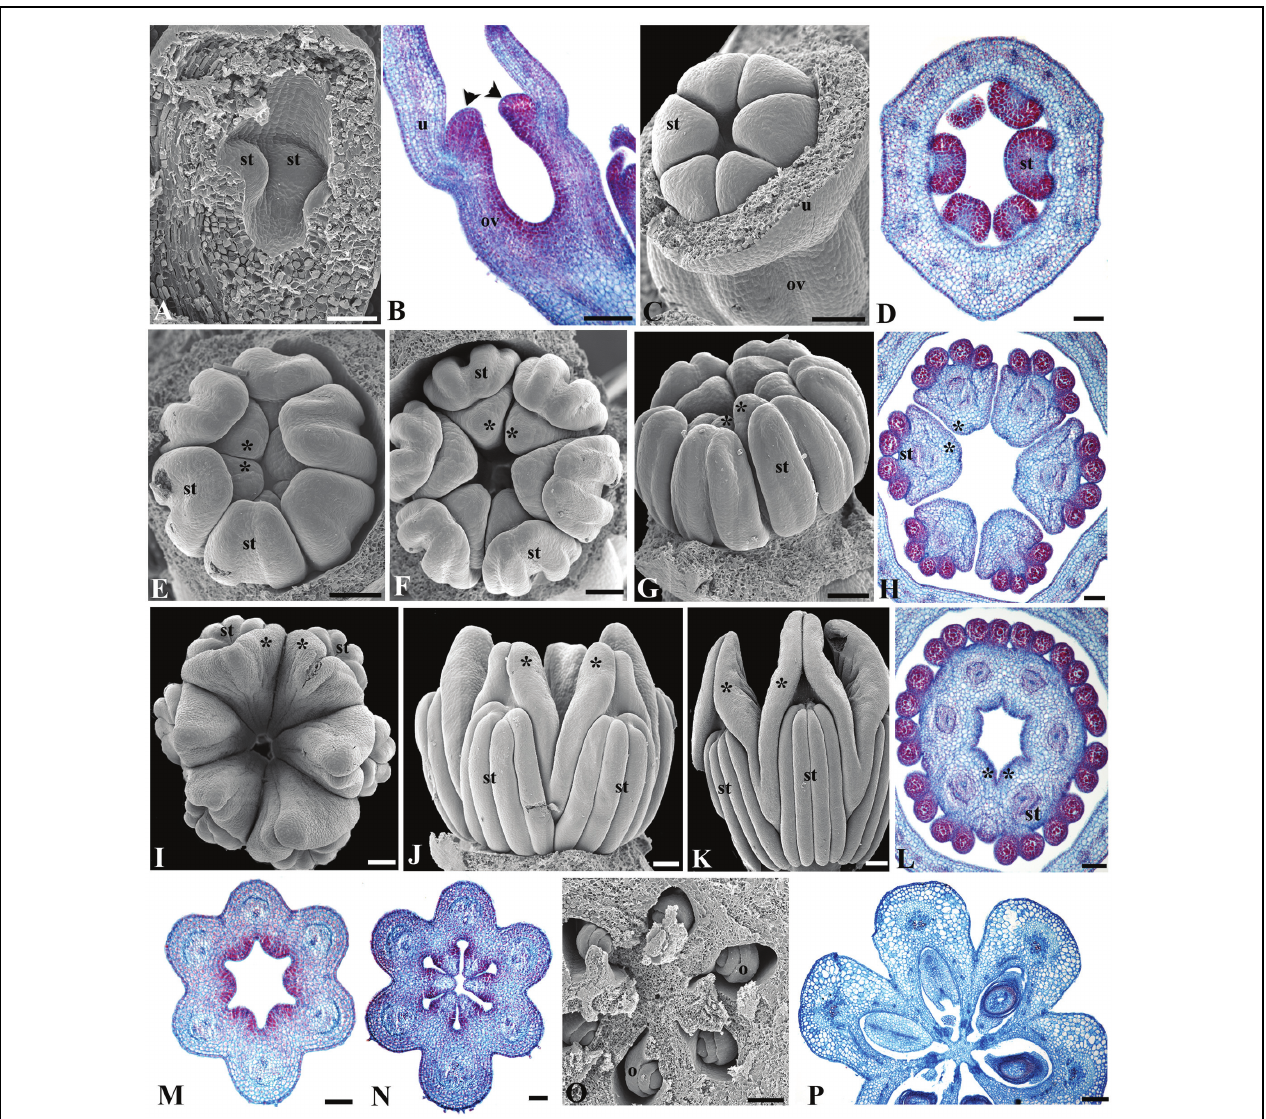
FIGURE 3 | Aristolochia fimbriata , gynostemium and ovary development. (A,B) Stamen initiation above the forming inferior ovary at S3. (C,D ) Anther growth and formation of the sporogenous tissue at S4. (E–G) Two successive stages of gynostemium development at S5 (E) and S6 (F,G) . (H) Transverse section of the gynostemium at S6. (I–K) Top (I) and lateral (J,K) views of the “female” stage of gynostemium with stigmatic lobes growing above the staminal tissue at S7. (L) Transverse section of the gynostemium at S7 with carpellary tissue growing between the anthers. (M–O) Successive stages of ovary development at S6 (M,N) and S7 (O) . (P) Ovary during transition to fruit (P) . o, ovule; ov, ovary; st, stamen; u, utricle; black arrowheads indicate anthers; asterisks ( ∗ ) indicate stigmas. Scale Bars (A,B,L) : 60 μ m; (C,E–G,J,O,P) : 100 μ m; (D,H,M) : 50 μ m; (I) , 200 μ m; (K) , 300 μ m; (N) , 80 μ